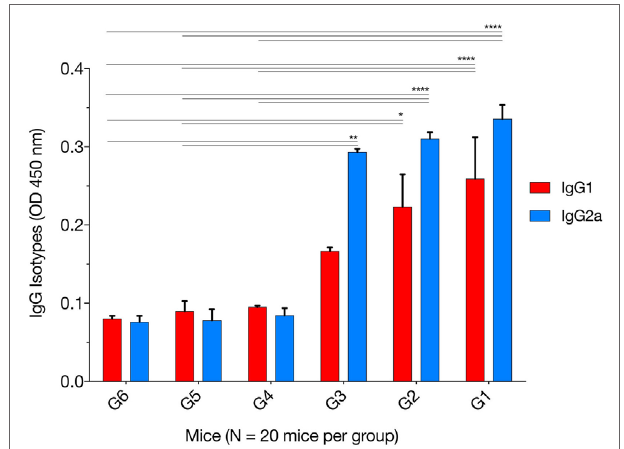
FigUre 2 | Levels of IgG subclasses (IgG1 and IgG2a) in the sera of mice 2 weeks after the final booster immunization. The patterns of IgG2a to IgG1 post immunization using various immunization regimens suggest the induction of a mixed Th1/Th2 immune response. Experimental groups include G1: mice received pVAX1 plasmids containing five antigens (ROP16, ROP18, MIC6, CDPK3, and PF); G2: mice received pVAX1 plasmids containing four antigens (ROP16, ROP18, MIC6, and CDPK3); G3: mice received pVAX1-PF; G4: mice received an empty pVAX1; G5: mice received phosphate-buffered saline alone; G6: healthy control mice. Each bar represents the group OD 450 ± SDs for three wells (representative of three experiments). * p < 0.05, ** p < 0.01, and **** p < 0.0001, compared with the control groups.